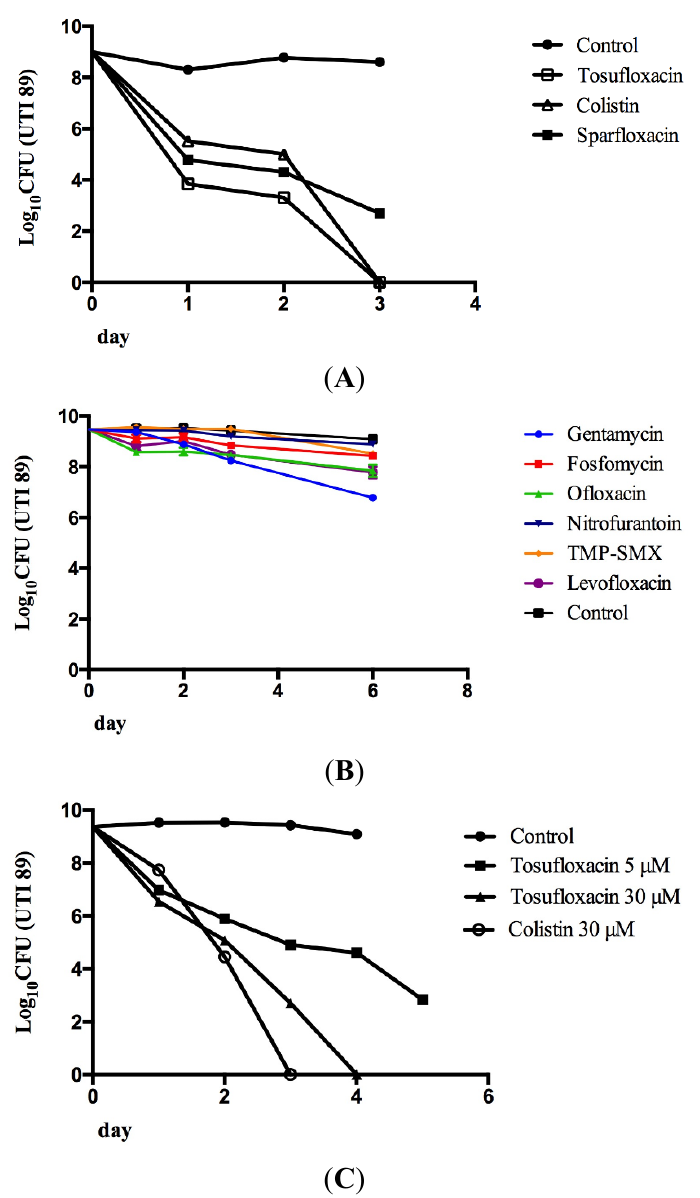
Figure 2. Activity of persister active drug candidates and selected conventional UTI antibiotics against E. coli UTI89 persisters. E. coli UTI89 stationary phase culture was treated with ofloxacin (5 μg/mL) for 4 hours to enrich persisters. Then, the surviving persisters from the treatment were subjected to drug exposure with different antibiotics as described in the text. The bacterial viability was determined by CFU count. ( A ) Tosulfloxacin (50 μM) and colistin (50 μM) killed persisters more effectively than sparfloxacin (50 μM) and completely eliminated persisters after 3 days; ( B ) Antibiotics commonly used to treat UTIs had poor activity against the UTI persisters. The final concentration of the UTI antibiotics including gentamicin, fosfomycin, ofloxacin, levofloxacin, nitrofurantoin and TMP-SMX, was all 50 μM. TMP-SMX is the combination of trimethoprim and sulfamethoxazole in a ratio of 5:1; ( C ) Activity of tosufloxacin (5 and 30 μM) and colistin (30 μM) at a lower concentrations against stationary phase E. coli UTI89